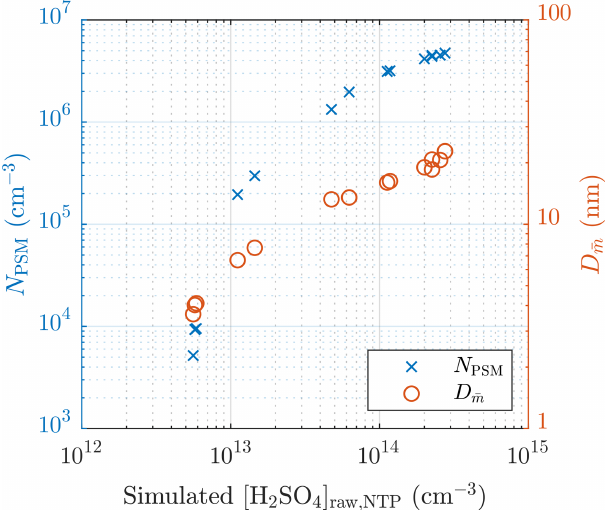
Figure 5. The measured number concentrations of the particles larger than ∼ 1 . 3nm and the diameters with the average mass of measurement set 1 as a function of the simulated H 2 SO 4 concen- tration in the raw sample. The particle number concentrations are multiplied by the total dilution ratio of the sampling system. The error bars for these values are shown later, in Fig. 13. The H 2 SO 4 concentrations are presented as the concentrations in NTP (normal temperature and pressure) conditions rather than in a hot raw sam-